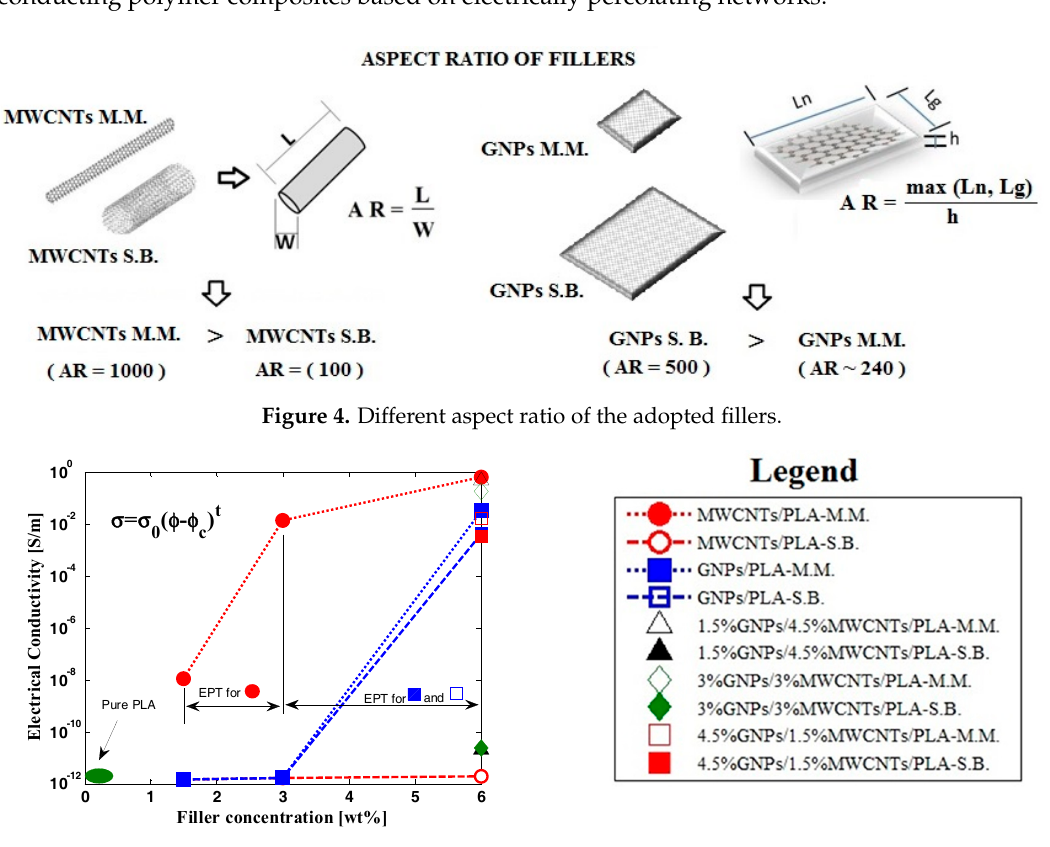
Figure 4. Different aspect ratio of the adopted fillers.